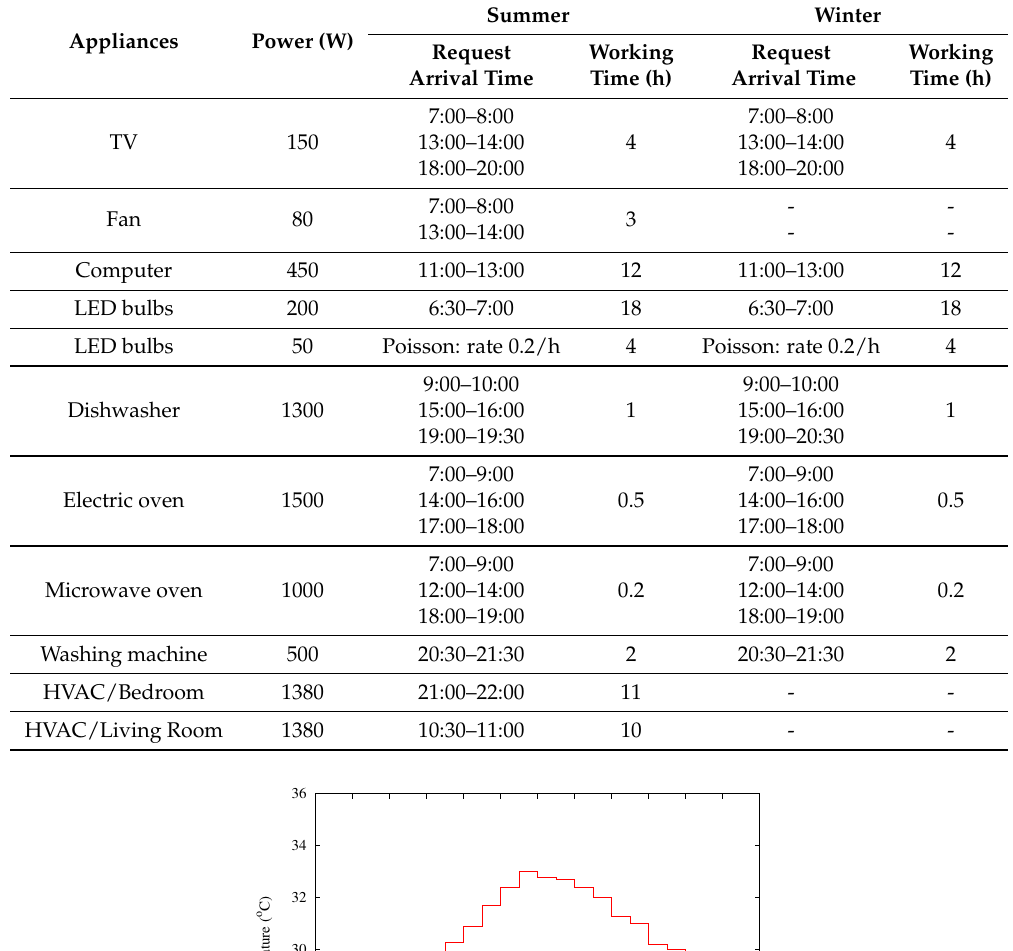
Table 5. Simulation parameters of home appliances used in simulations.